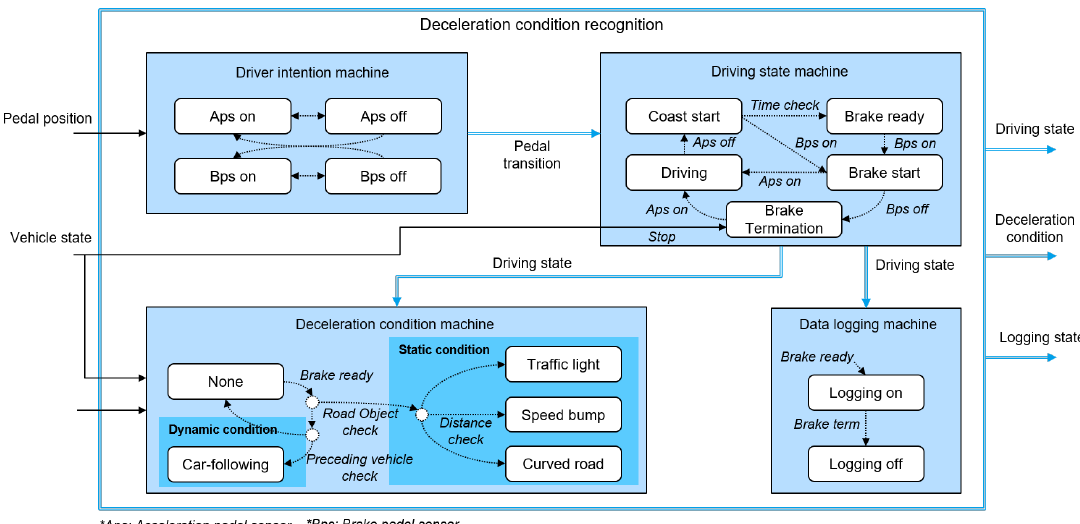
Figure 5. Diagram of the deceleration condition recognition